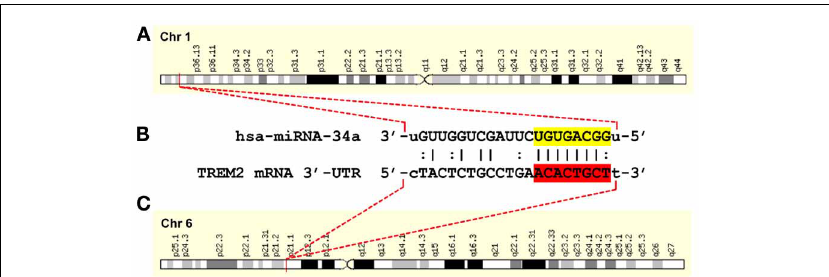
FIGURE 1 | A hsa-miRNA-34a-TREM2-mRNA-3 (cid:2) -UTR complementarity map; gene products on two independent chromosomes orchestrate a down-regulation of TREM2 and a progressive deficit in cellular debris sensing, phagocytosis and clearance in human neurodegenerative disease. (A) an NF- κ B-sensitive miRNA-34a (encoded at chr1p36.22) and up-regulated in AD has been found to target (B) the central domain of the 299 nucleotide human TREM2 mRNA 3 (cid:3) -untranslated region (3 (cid:3) -UTR) of the TREM2 gene (C) encoded at chr6p21.1; thus the functional interaction of 2 independent gene products may be responsible for TREM2 deficits in sporadic AD; in (B) the miRNA-34a seed sequence 3 (cid:3) -UGUGACGG-5 (cid:3) is highlighted in yellow; the complementary TREM2-3 (cid:3) -UTR recognition sequence 5 (cid:3) -ACACTGCT-3 (cid:3) is highlighted in red; an “|” indicates a full hydrogen bond between miRNA-34a and the TREM2-mRNA-30-UTRand a “:” indicates a partial hydrogen bond; the hsa-miRNA-34a recognition feature is located about midway in the TREM2 mRNA-3 (cid:3) -UTR; other miRNA recognition features located within the TREM2-3 (cid:3) -UTR may also affect TREM2 mRNA stability and regulate its expression; other miRNA-mRNA pairings may also be involved in TREM-2 function; the TREM2 gene has no strong NF- κ B binding site within at least 11kb of its transcription start site (Zhao et al., 2013 and unpublished